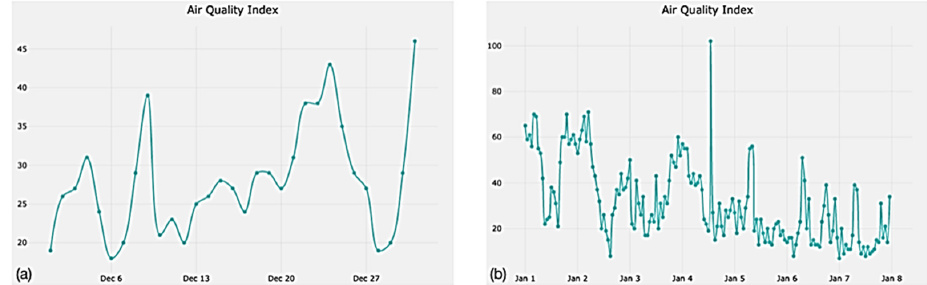
Figure 5. ( a ) Daily aggregate AQI time series for the Santo Domingo Campus Monitor for December 2020; ( b ) hourly aggregated AQI time series for the Santo Domingo Campus Monitor from 1 to 7